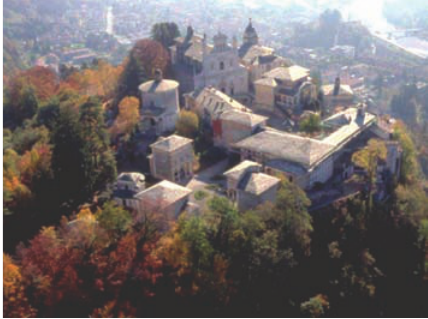
Figure 1: The Sacred Mountain of Varallo, Italy. Overview.